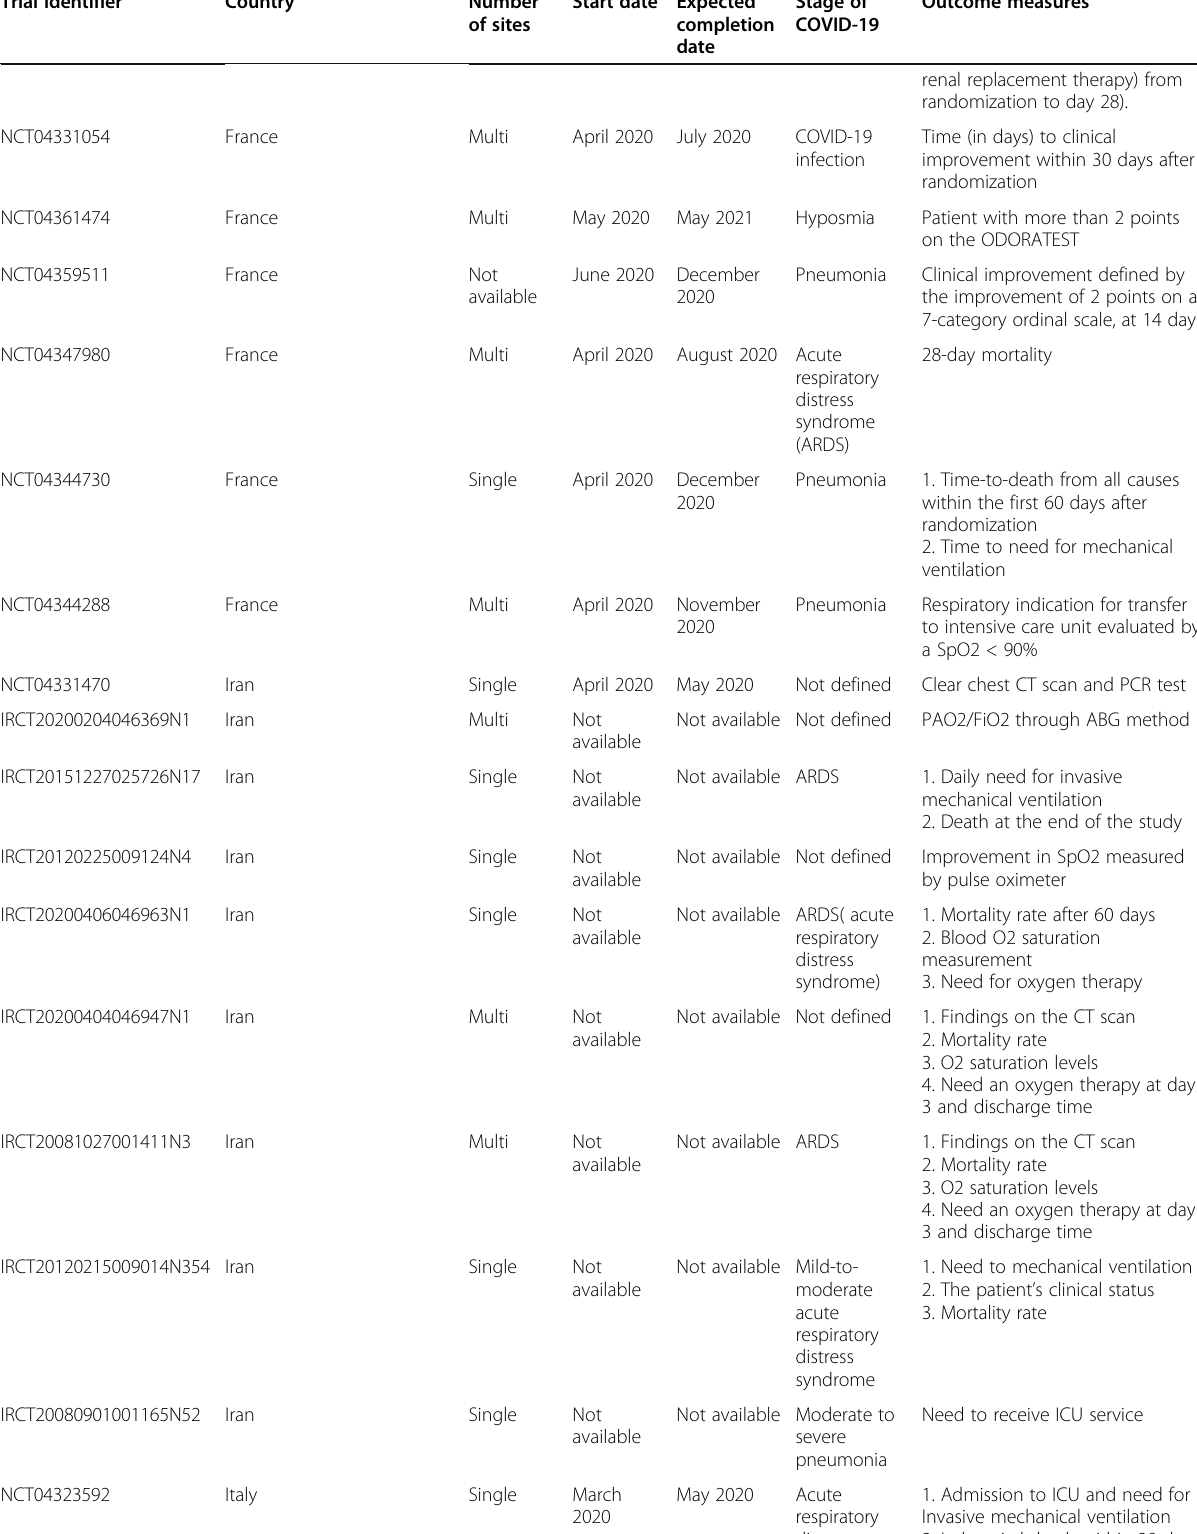
Table 1 General characteristics of the included trials